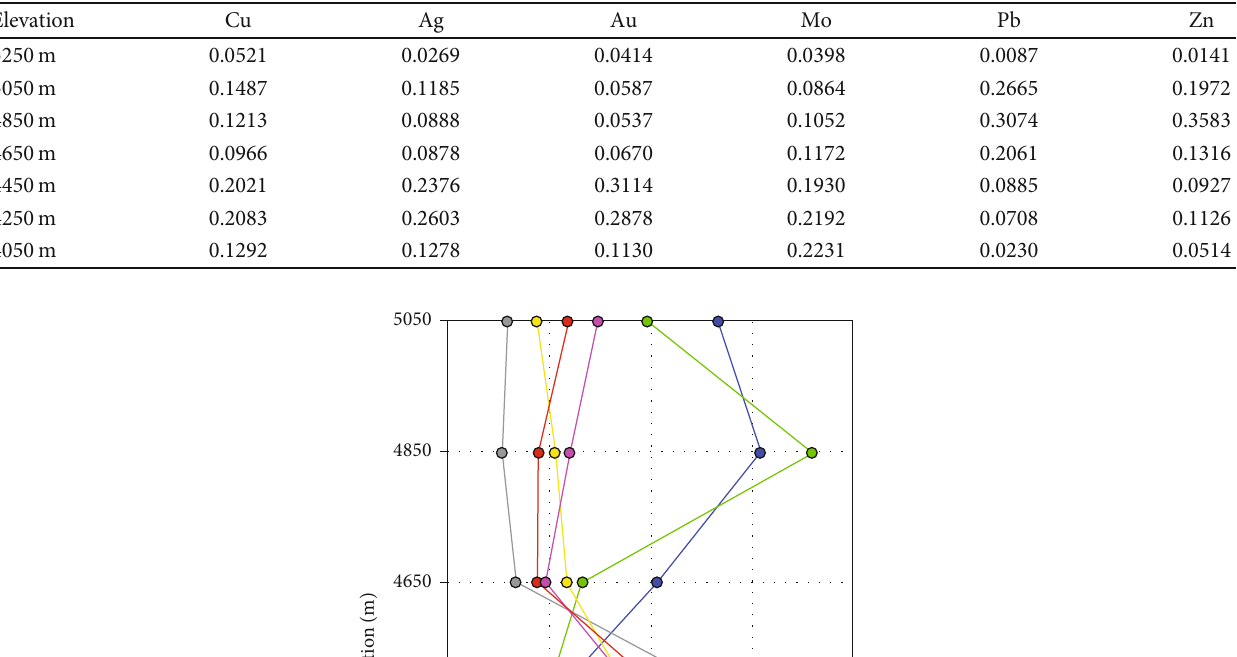
Table 1: Normalized areal metal productivities at di ff erent